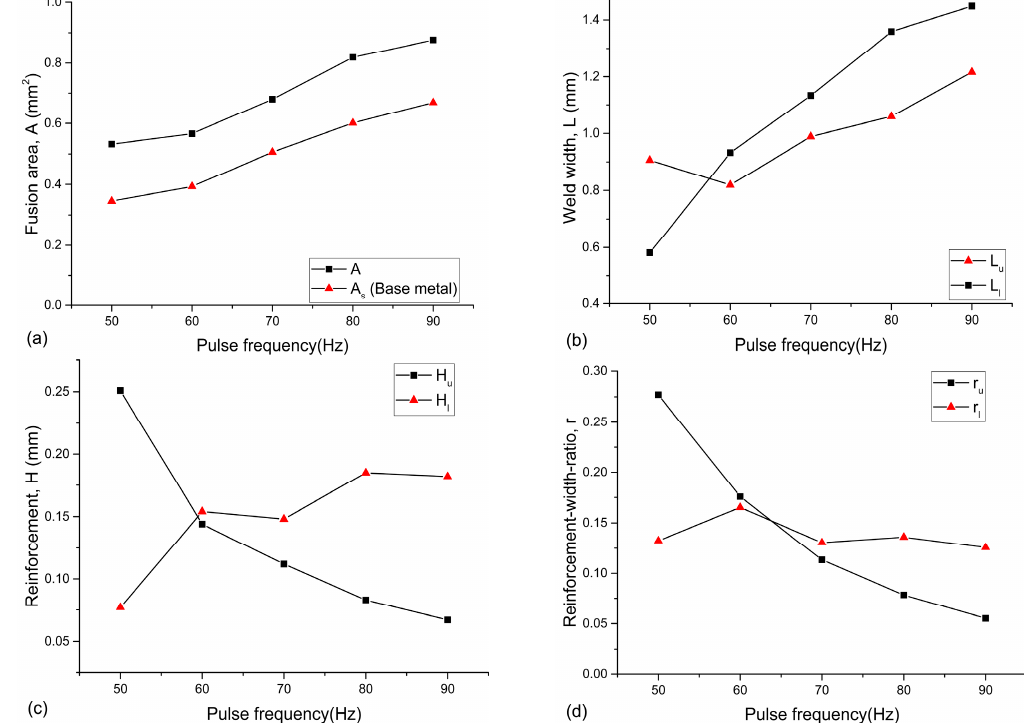
Figure 7. Variations of weld bead parameters with pulse frequency: ( a ) fusion zone area; ( b ) weld width; ( c ) reinforcement height; ( d ) reinforcement height ‐ to ‐ width ratio.